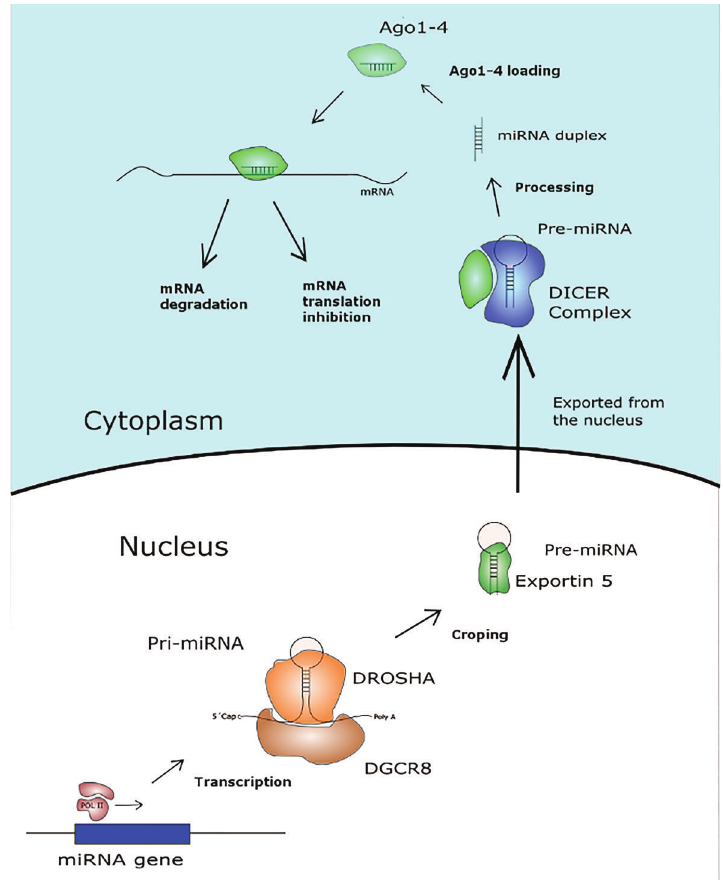
Figure 1. Main processes involved in the biogen- esis and mechanism of action of